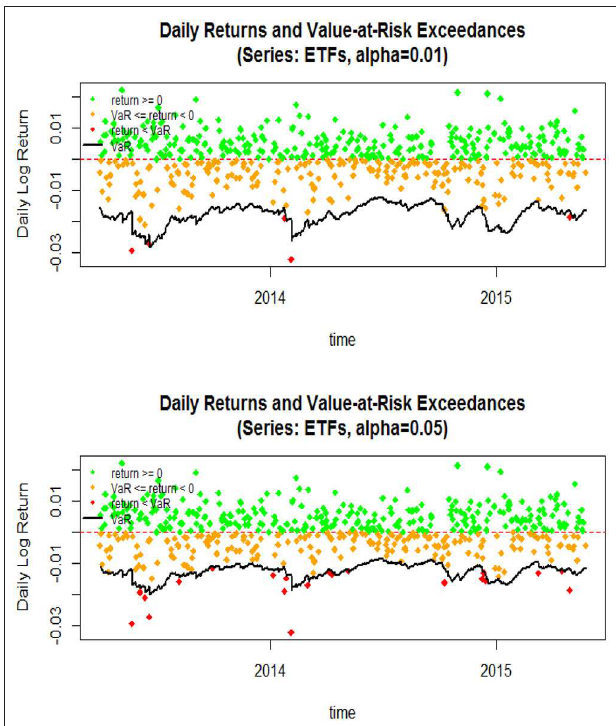
FIGURE 6 | VaR exceedances and daily